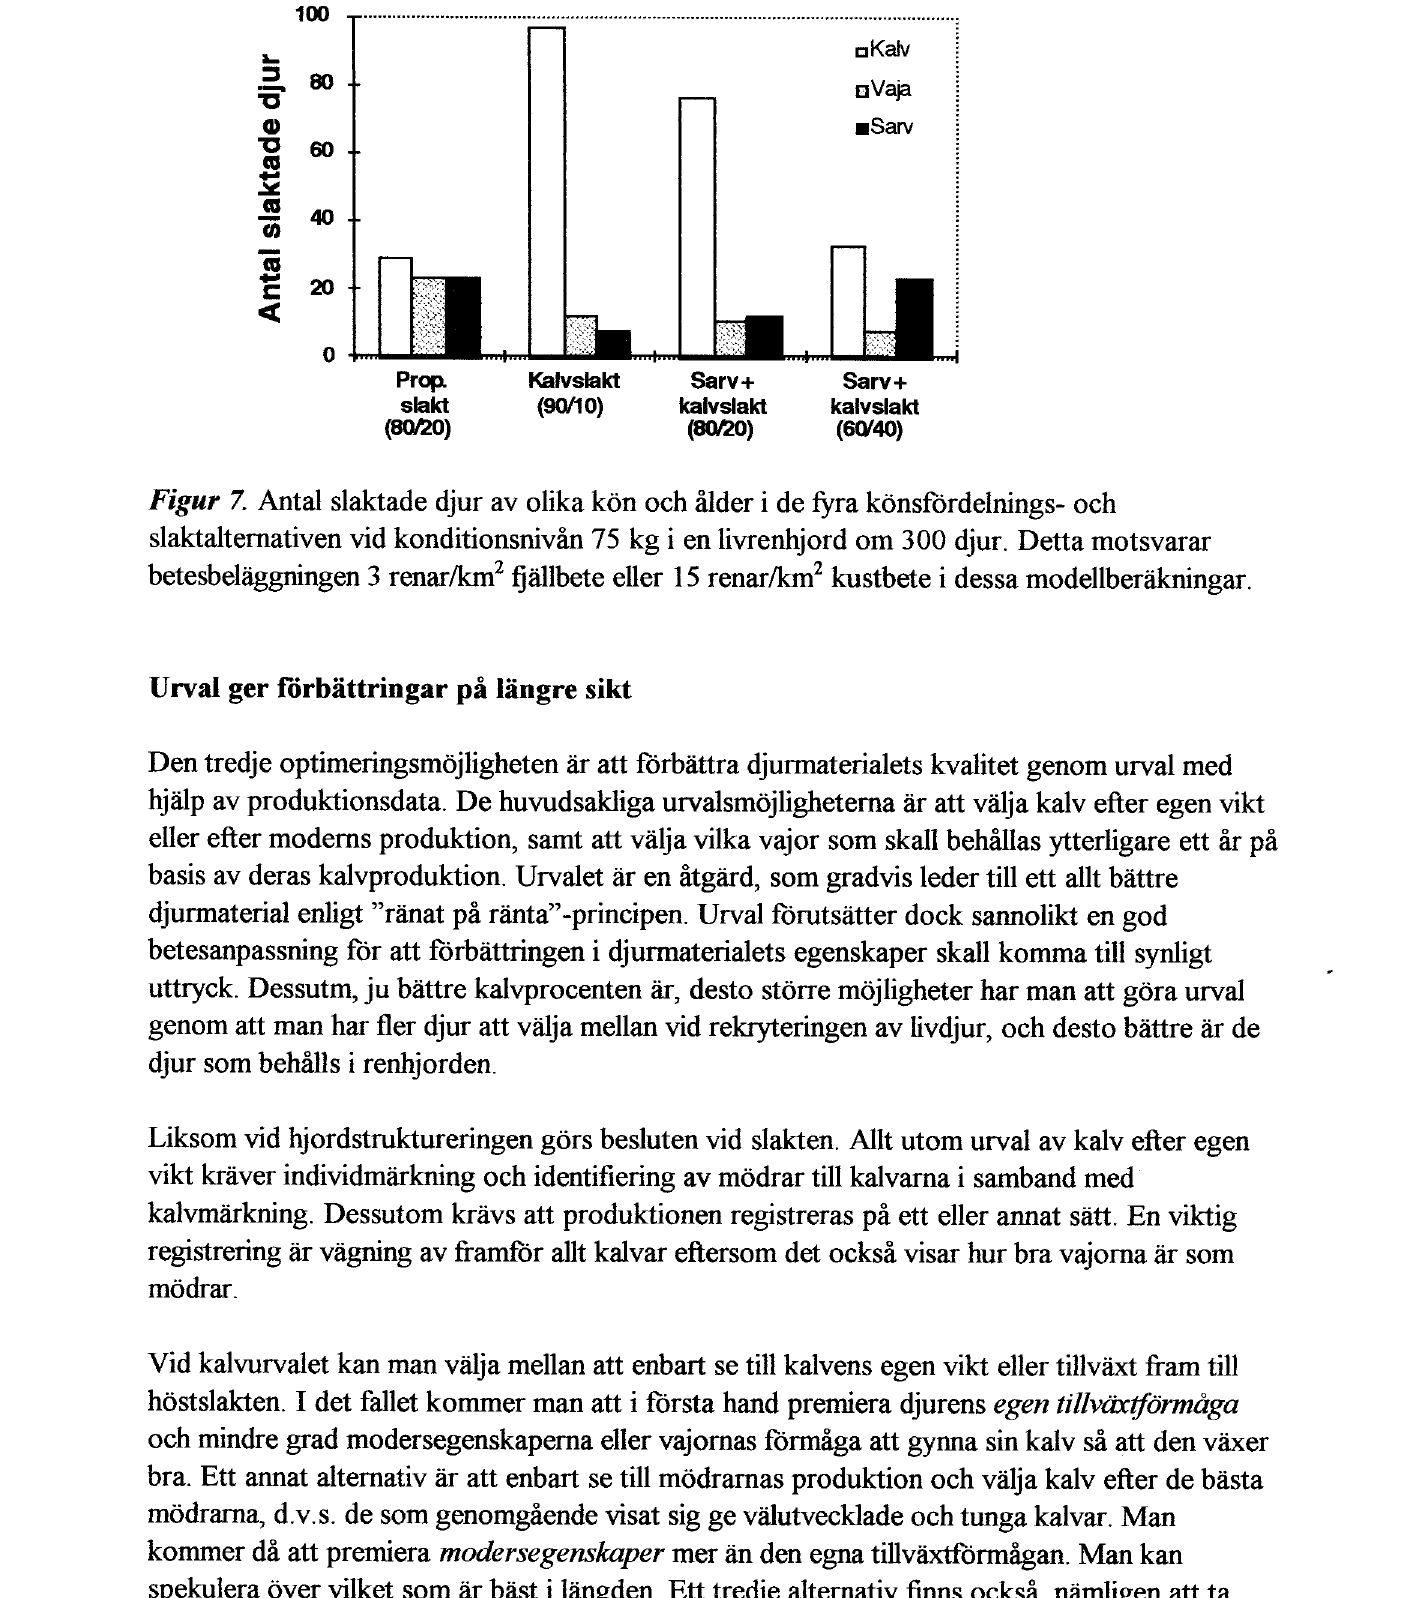
Figur 7. Antal slaktade djur av olika kon och ålder i de fyra konsfbrdelnings- och slaktalternativen vid konditionsnivån 75 kg i en livrenhjord om 300 djur. Detta motsvarar betesbelåggningen 3 renar/km 2 fjållbete eller 15 renar/km 2 kustbete i dessa modellberåkningar.